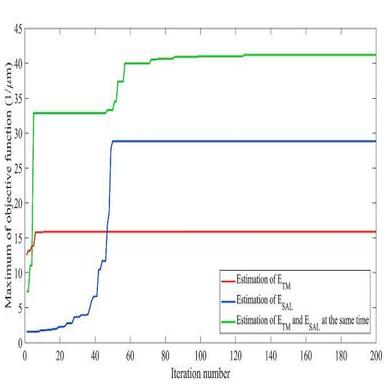
Best observed values of objective functions for the estimation the Young's modulus of the TM, Young's modulus of the SAL, and simultaneous estimation of the Young's modulus of TM and SAL with respect to the iteration number in the Bayesian optimization process. For the Young's modulus of the TM and SAL, the Bayesian optimization converges after about 7 and 50 iterations, respectively, while for the simultaneous estimation of these two parameters, the Bayesian optimization converges almost after about 90 it